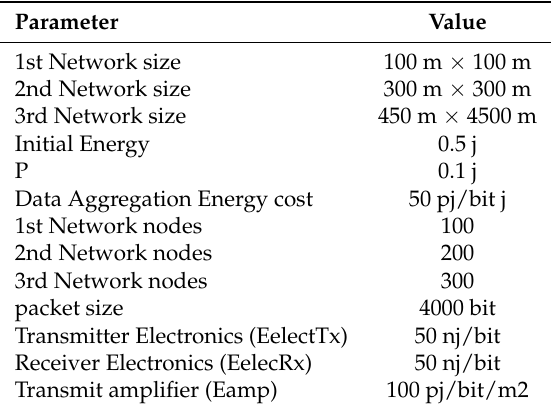
Table 2. General simulation